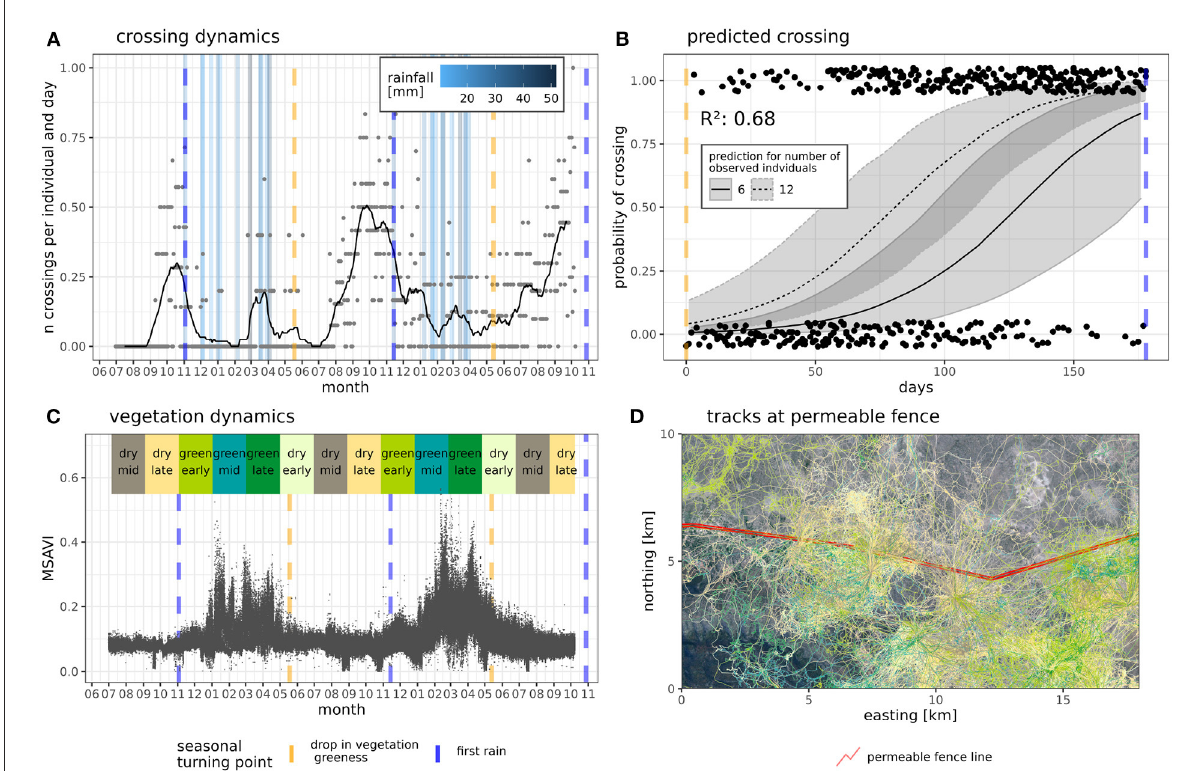
FIGURE3 Fence interaction dynamics and predictions. (A) Number of crossings averaged by number of observed individuals between June 2019 and Nov 2021 (points), trend from time series (line) and rainfall events (vertical bars, see legend). (B) Observed fence interactions (binomial, jittered points) and probability of fence crossing (binomial regression line) between dry season and first rain event. Orange dashed line indicates drop in vegetation greenness in dry season, vertical blue dashed line marks first rain event of the respective year. Prediction of crossing probability (line) with 95% confidence intervals of binomial regression based on differing numbers of observed individuals (see linetype in legend). (C) MSAVI values at each GPS location (points) and range of season (colored rectangles on top) for clarification of seasonal dynamics. (D) Map of example extent with movement tracks and permeable fence line (South of line—private wildlife reserve, North of line—Etosha National Park). Tracks are color coded by season [see season colors in (C)